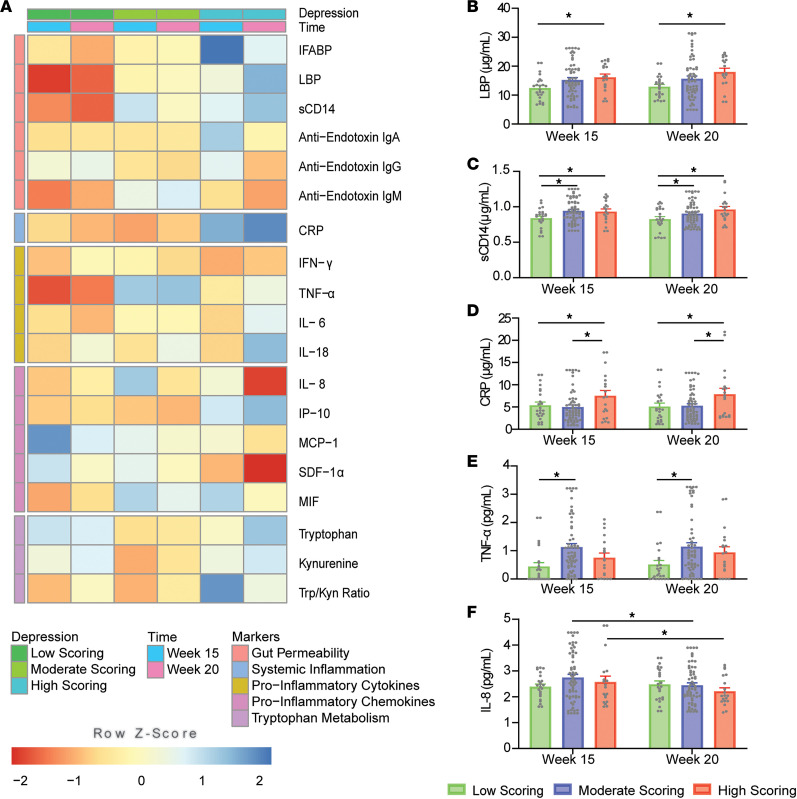
Differences in EPDS scoring groups across gestational time points in the healthy cohort (N = 24/61/19 from low/moderate/high).(A) Heatmap of normalized biomarker means across scoring groups and time points. Individual boxes are represented on a scale from red to blue. Darker red boxes represent markers whose concentrations were found to be greater than 1 standard deviation lower than the mean concentration across stress group and time point. Darker blue boxes represent markers whose concentrations were found to be greater than 1 standard deviation higher than the mean concentration across stress group and time point. Lower z scores are evident for LBP, sCD14, and TNF-α in the low-scoring group at 15 and 20 weeks and for IL-8 and SDF-1α in the high-scoring group at 20 weeks. Higher z scores are evident for IFABP and Trp/Kyn ratio in the high-scoring group at 15 weeks and for CRP in the high-scoring group at 15 and 20 weeks. Significant differences between EPDS-scoring groups are illustrated for (B) LBP, (C) sCD14, (D) CRP, (E) TNF-α, and (F) IL-8 (2-way ANOVA with Tukey’s HSD). *P < 0.05.